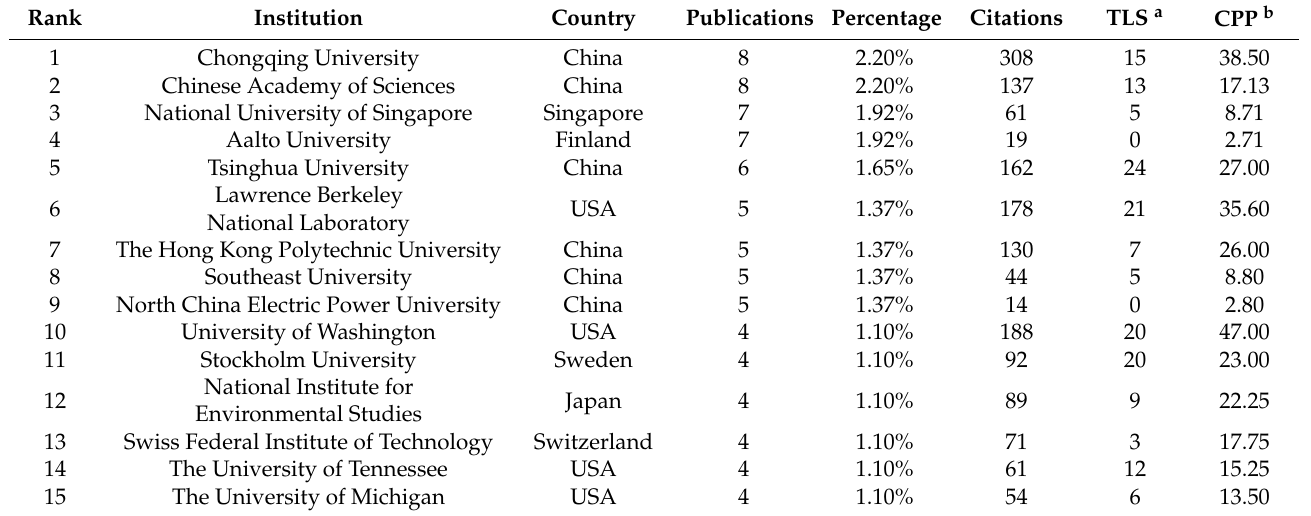
Table 3. Top 15 institutions with the most publications on CPCN in